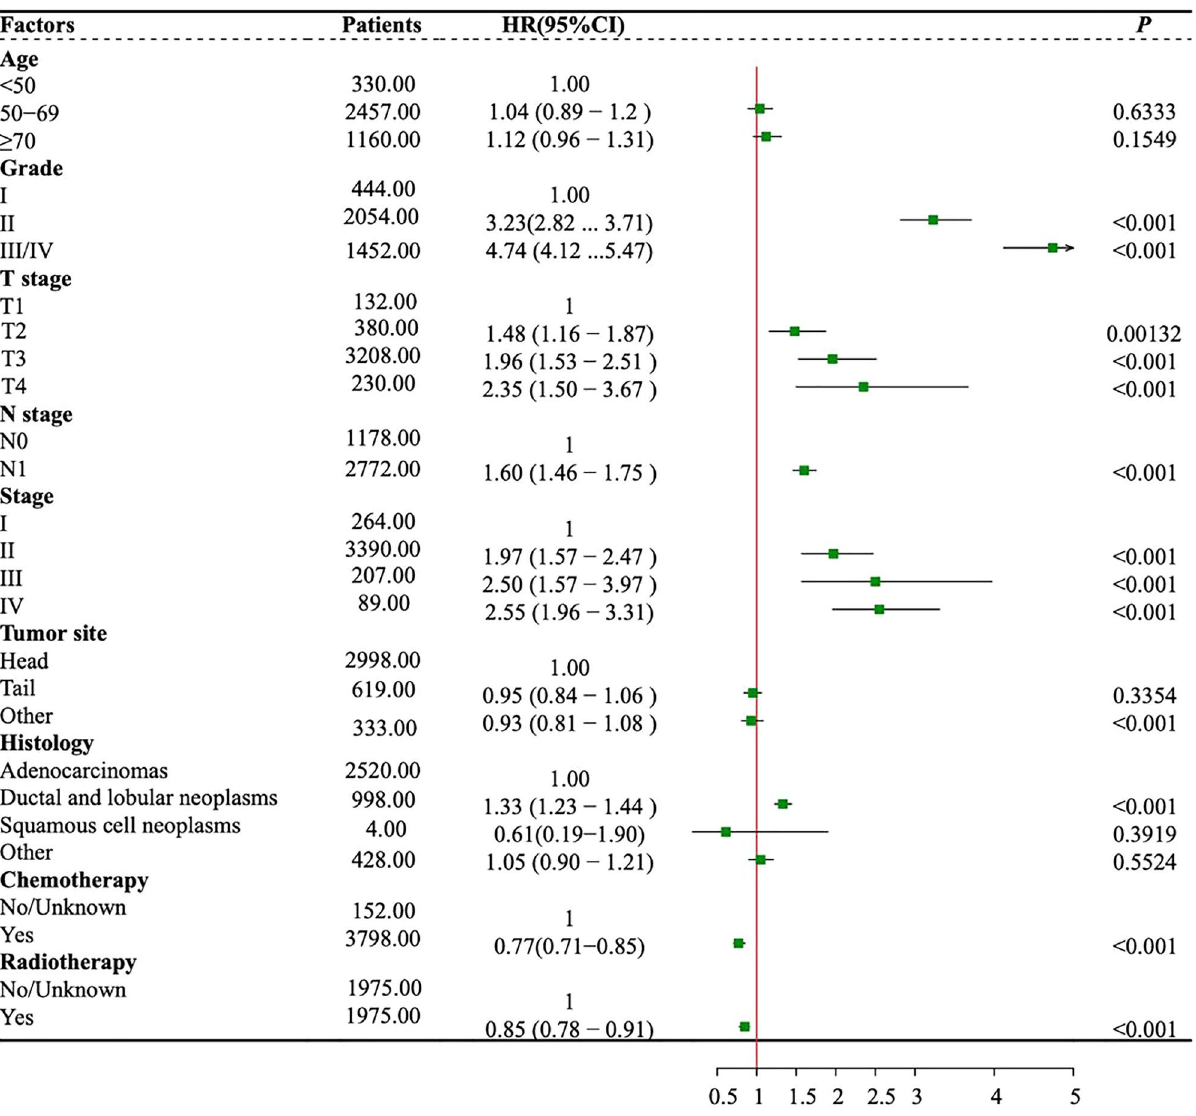
Figure 2. Hazard ratio in OS Cox analysis after PSM. OS Overall survival, PSM Propensity score matching, HR Hazard ratio, CI Confidence